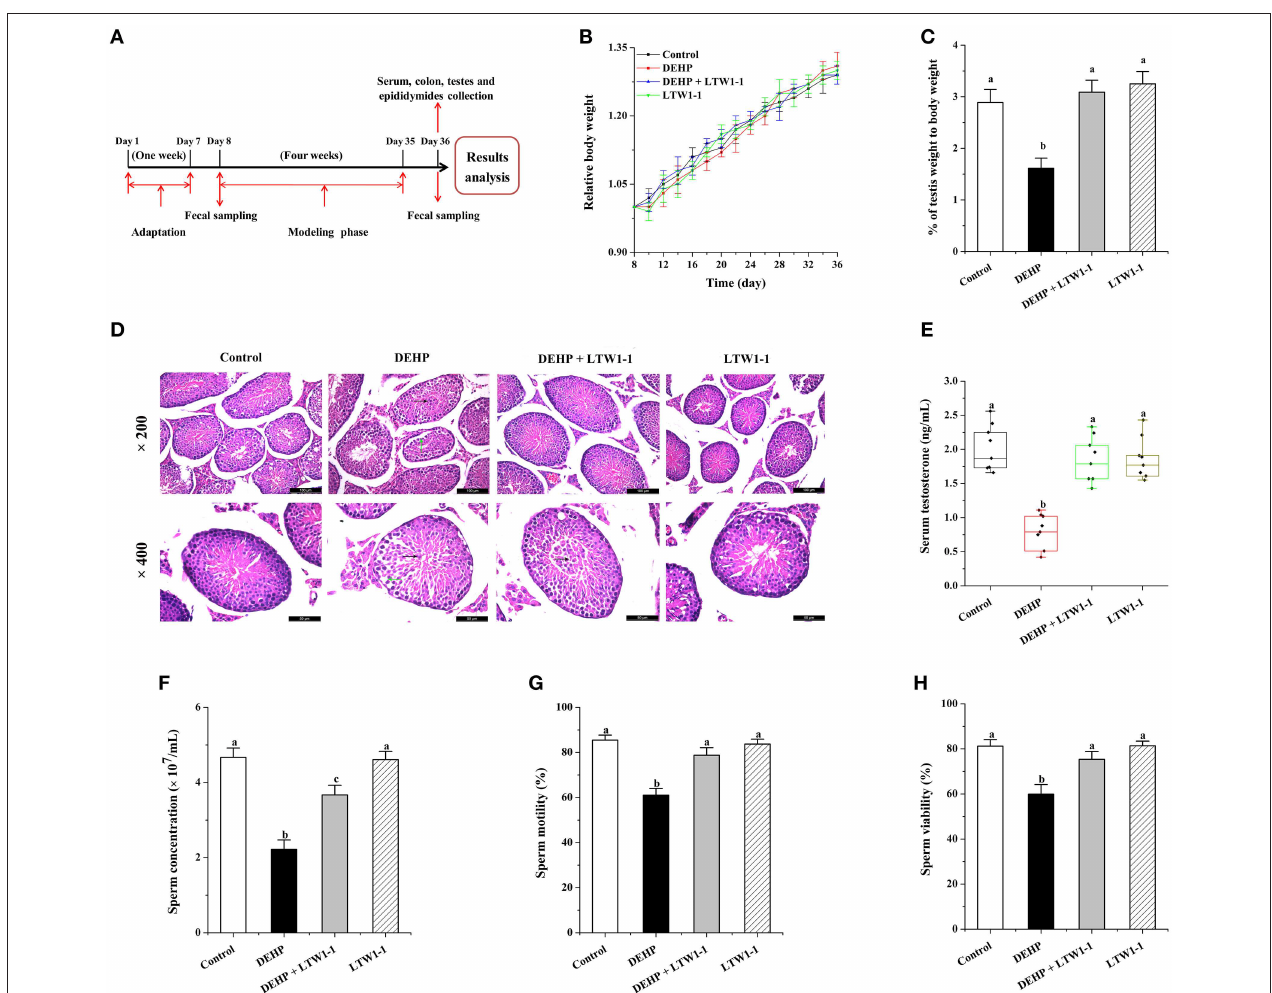
FIGURE 1 | Effects of L. plantarum TW1-1 treatment on mouse growth and development in the different groups. (A) Experimental design. (B) The relative body weight curve of the four groups of mice during the 4 weeks of intervention. The relative body weight was calculated as the percentage of baseline weight for each mouse. (C) Average testis weight relative to the body weight for each mouse. (D) Photomicrographs of Hematoxylin and eosin stained testicular sections. Green arrows indicate the seminiferous tubules with reduced thickness of the germinal epithelium and black arrows indicate an irregular arrangement of germ cells in the seminiferous tubules with exfoliation of germ cells into the lumen. (E) Changes in testosterone levels in the different groups. (F) Sperm concentration. (G) Sperm motility. (H) Sperm viability. The data are expressed as mean ± S.E.M. ( n = 8), different letters represent significant differences between groups by Tukey’s test ( P <